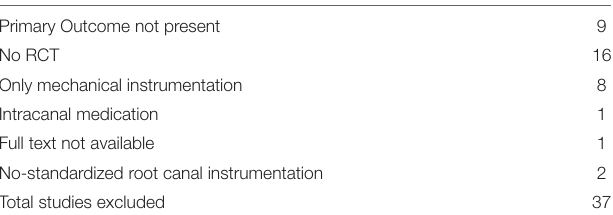
TABLE 1 | Reasons for